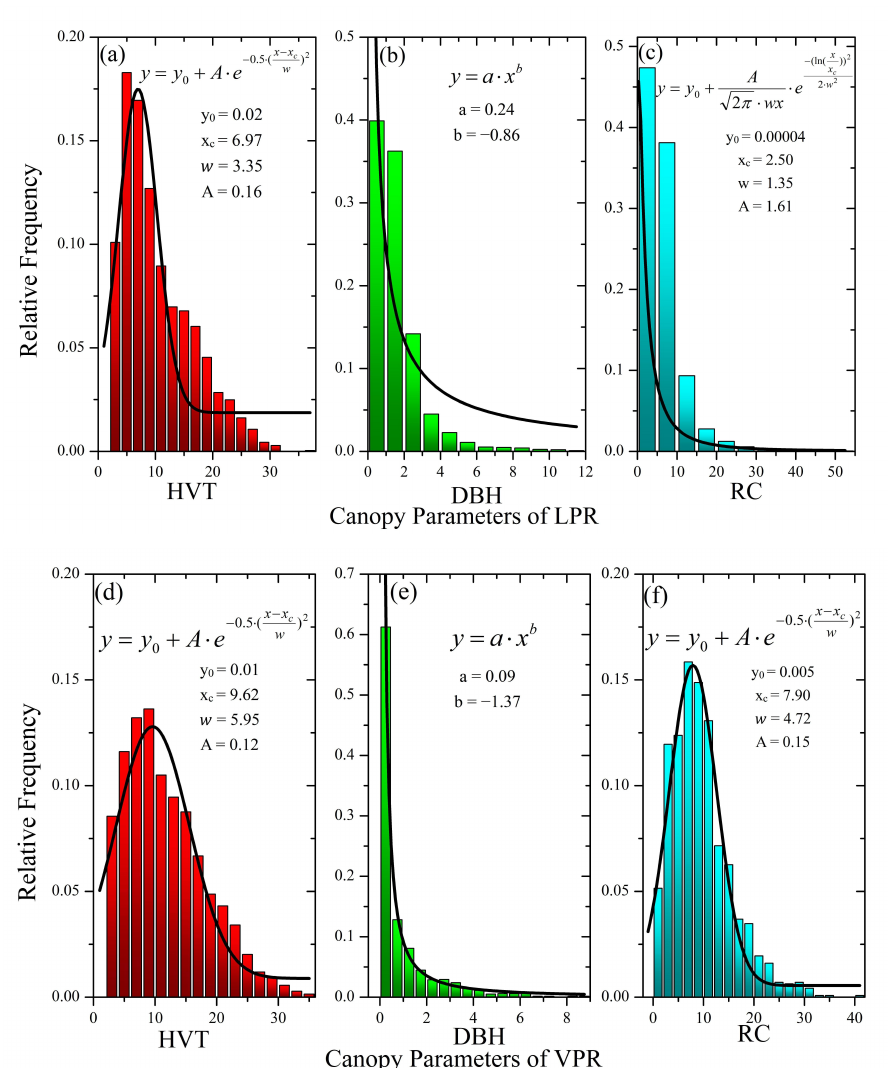
Figure 4. Histograms of the distributions of canopy parameters obtained from LPR ( a – c ) and VPR ( d – f ). Black curves are fits to the canopy parameter distributions.